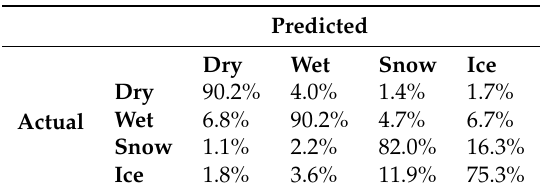
Figure 4. An instance of the classification tree with majority set to 95% and depth equal to 5. Table 3. Confusion matrix.